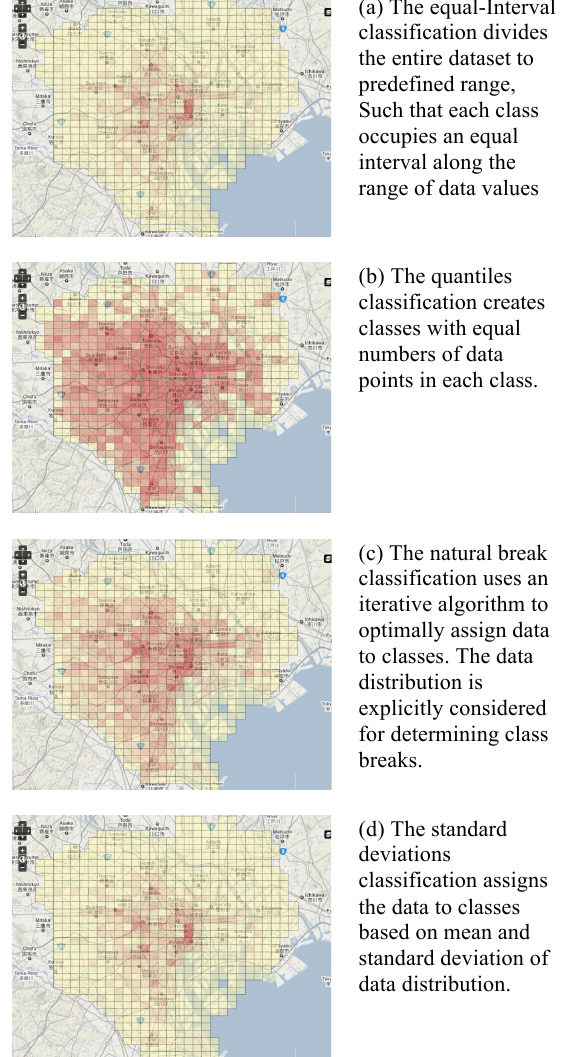
Figure 5. A sample visualization of choropleth maps created by different classification schemes to display the population density in central Tokyo at 10 am. on the